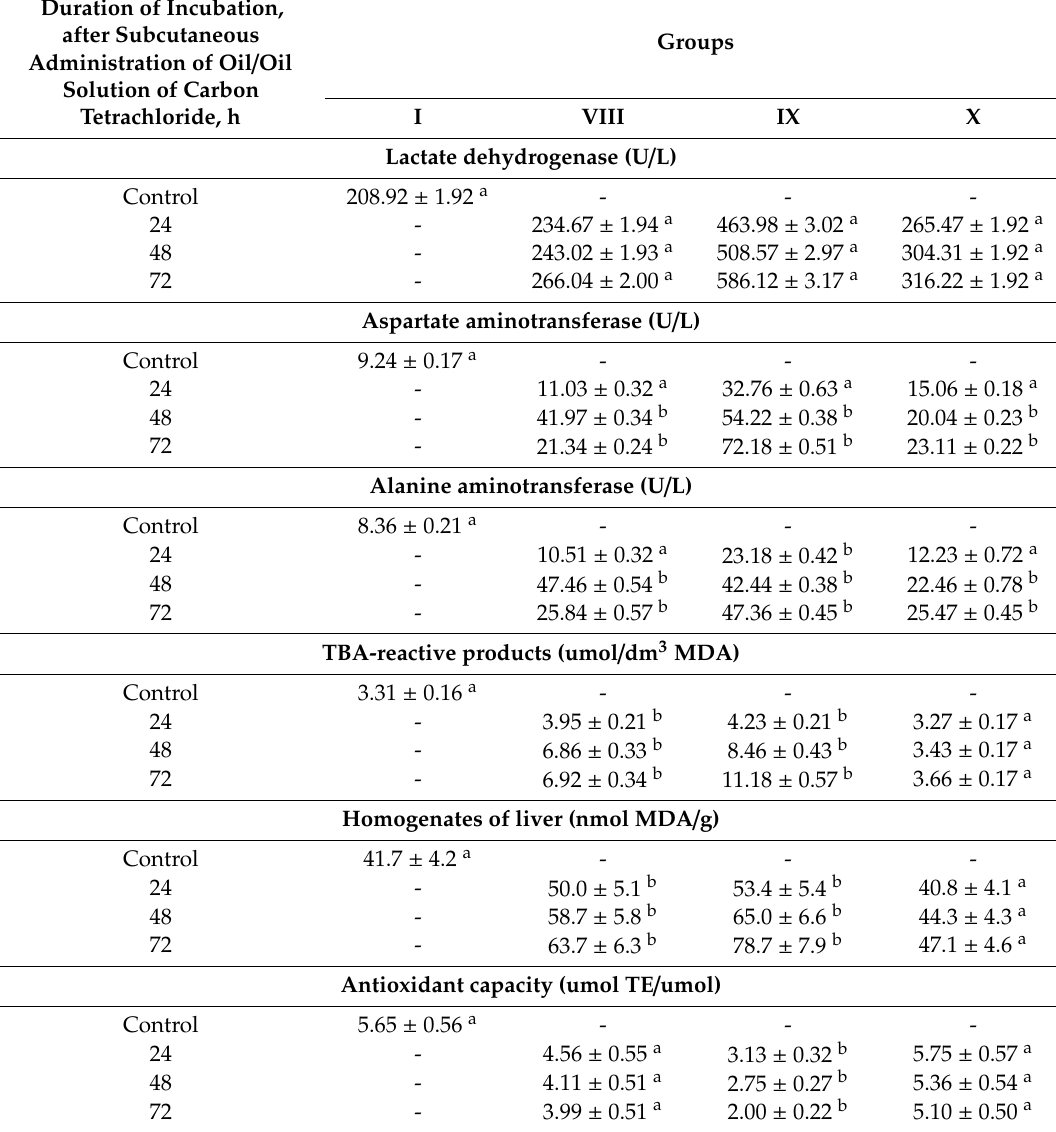
Table 4. Indicators of oxidative processes in the liver and blood serum antioxidant activity of laboratory